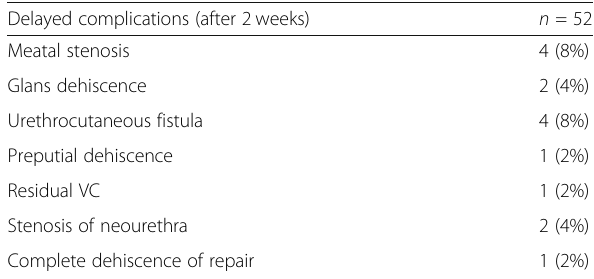
Table 9 Delayed complications after surgery (after 2 weeks postoperatively)